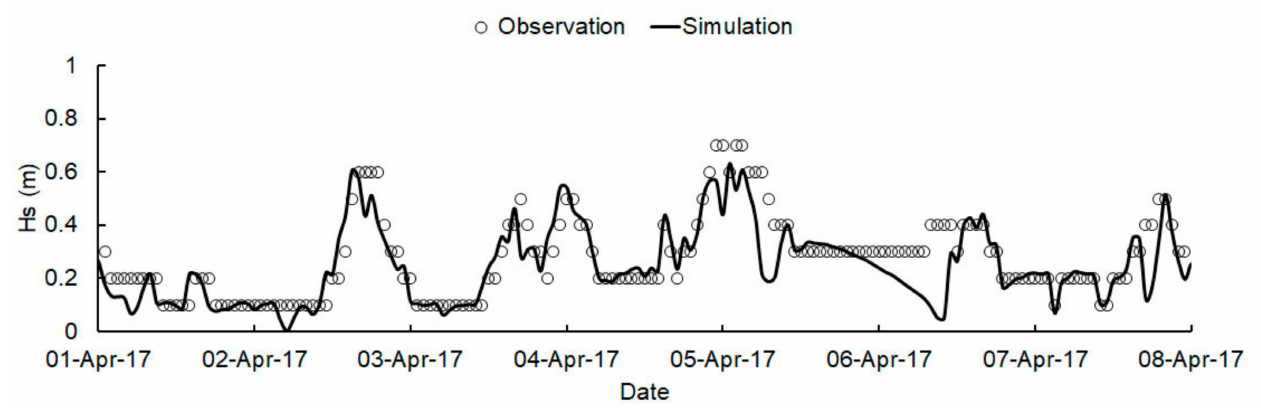
Figure 3. Time series of simulated and observed tidal levels at ( a ) Qinhuangdao tidal station T1 and ( b ) Shanhai Pass tidal station T2, and tidal current velocity magnitude ( c ) and direction ( d ) at Shanhai Pass tidal station T2.